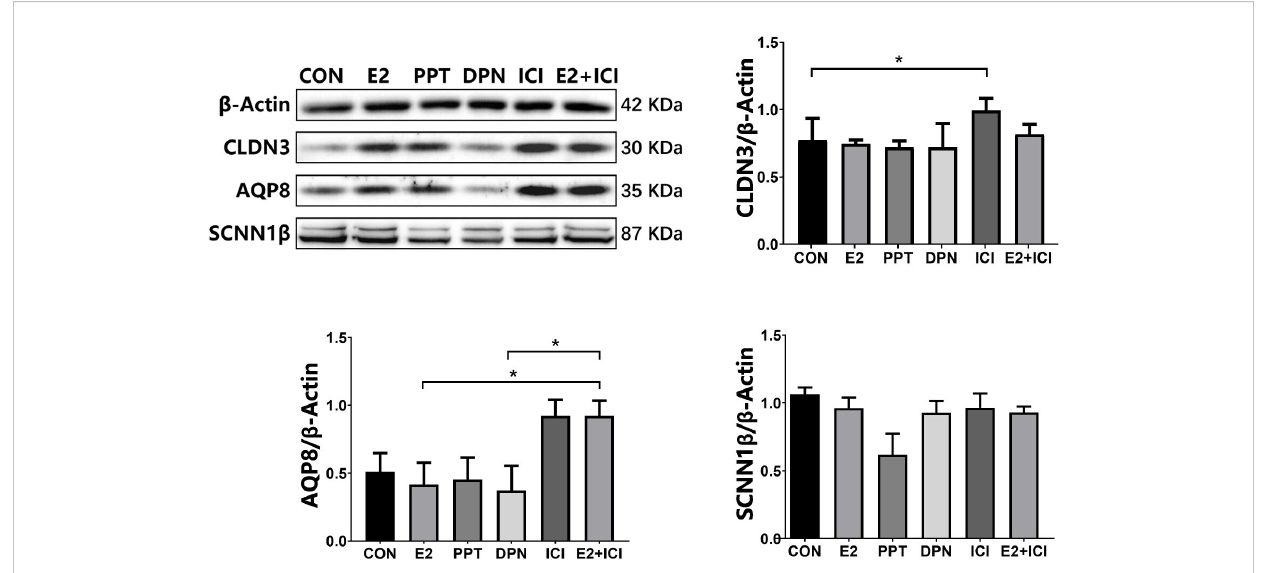
FIGURE 7 protein expression of CLDN3, AQP8, and SCNN1 b in RL95-2 cell line. CON: control group, E2: treat with 10 -6 M oestrogen, PPT: treat with 10 -6 M ER a agonist, DPN: treat with 10 -6 M ER b agonist, ICI: treat with 10 -6 M oestrogen receptor antagonist, E2+ICI: treat with both 10 -6 M E2 and 10 -6 M ICI.